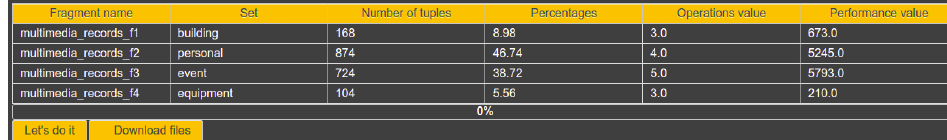
Figure 9. Selection of the attribute that describes the multimedia attribute. The values of the last two columns are obtained from the log file. The calculation of